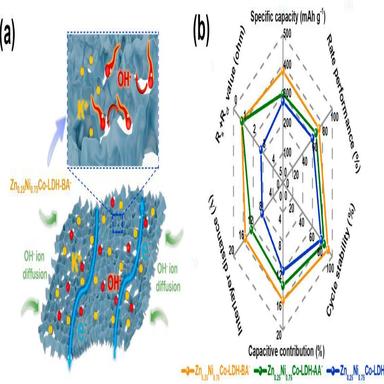
(a) Schematic illustration revealing the merits of rationally designed 2D porous Zn0.25Ni0.75Co-LDH-BA– thin sheets. (b) Overall electrochemical performance evaluation of Zn0.25Ni0.75Co-LDH-BA– /AA– /NO3 − .